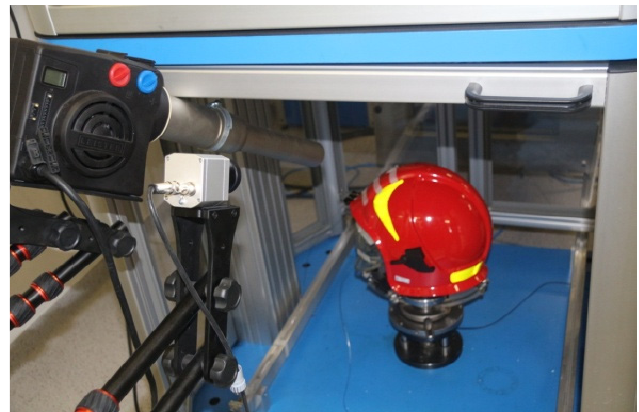
Figure 7. Firefighting helmet CV102 (a helmet shell and some other elements are made of Ultramid PA66-GF25FR) placed on a static head model, located in a measurement track of a drop hammer DFP 1000, which was treated with the hot airflow (air heater HOTWIND SYSTEM).